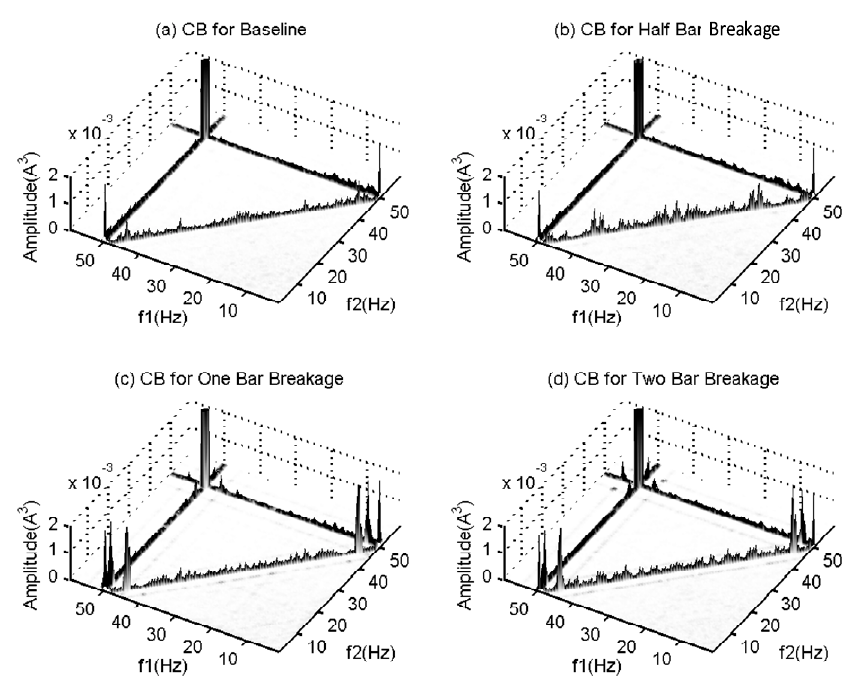
Figure 6. CB amplitudes for baseline motor and BRB cases.